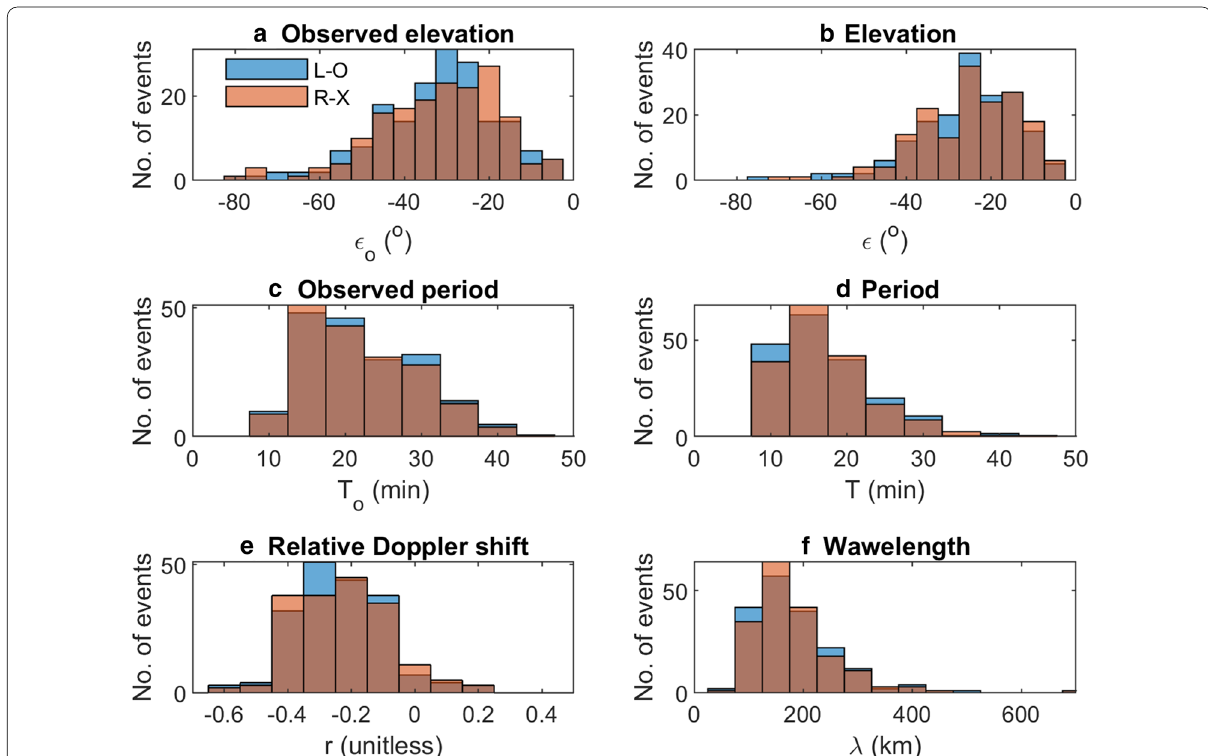
Fig. 3 Distribution of selected GW characteristics for the period July 2014–June 2015 (solar maximum) assuming L-O mode (blue) and R-X mode (orange) signals. a observed elevation ǫ o , b elevation, c observed period T o , d period T , e relative Doppler shift r , f wavelength